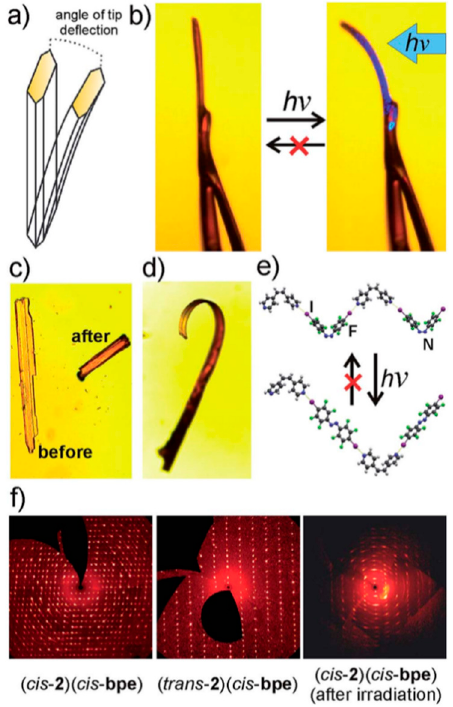
Figure 7. Irreversible photomechanical bending of a plate-like co-crystal of 17 . Reprinted with permission from [44]. Copyright 2014 Royal Society of Chemistry.